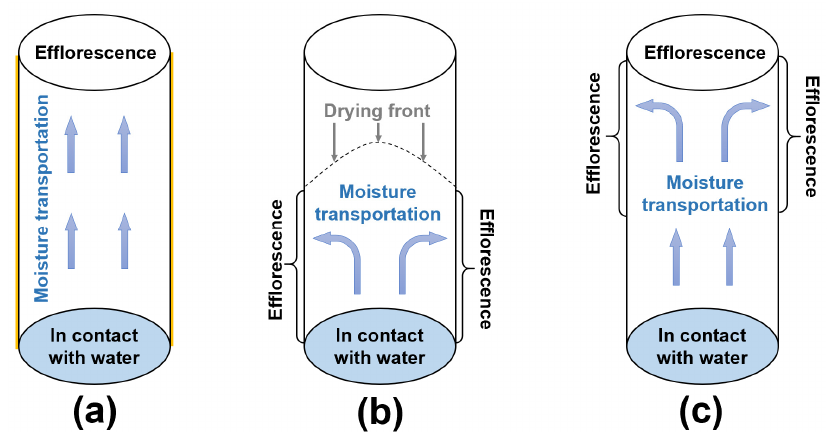
Figure 11. ( a – c ) Schematic diagram of moisture transportation in the geopolymer cylinders after different curing regimes.